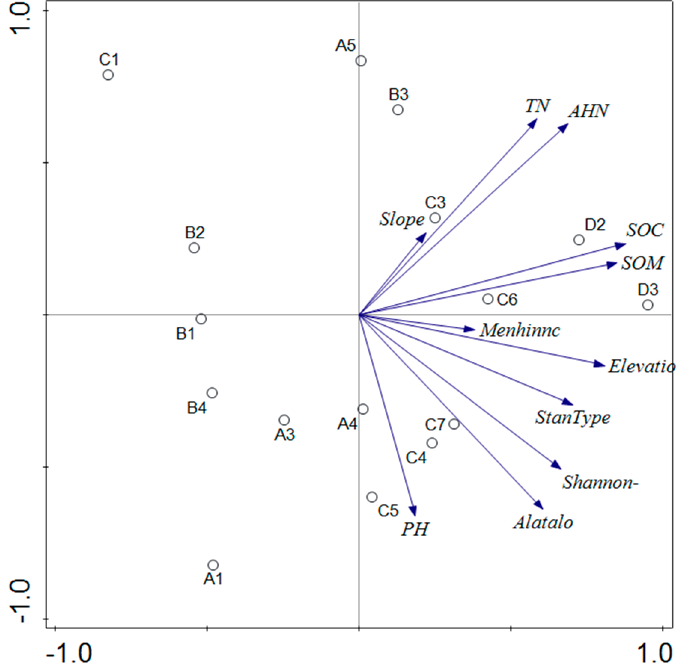
Figure 4. Samples − species − environmental variables triplot of RDA analysis. The blue arrows represent the environment and response variables, while the black circle represents sampling sites.